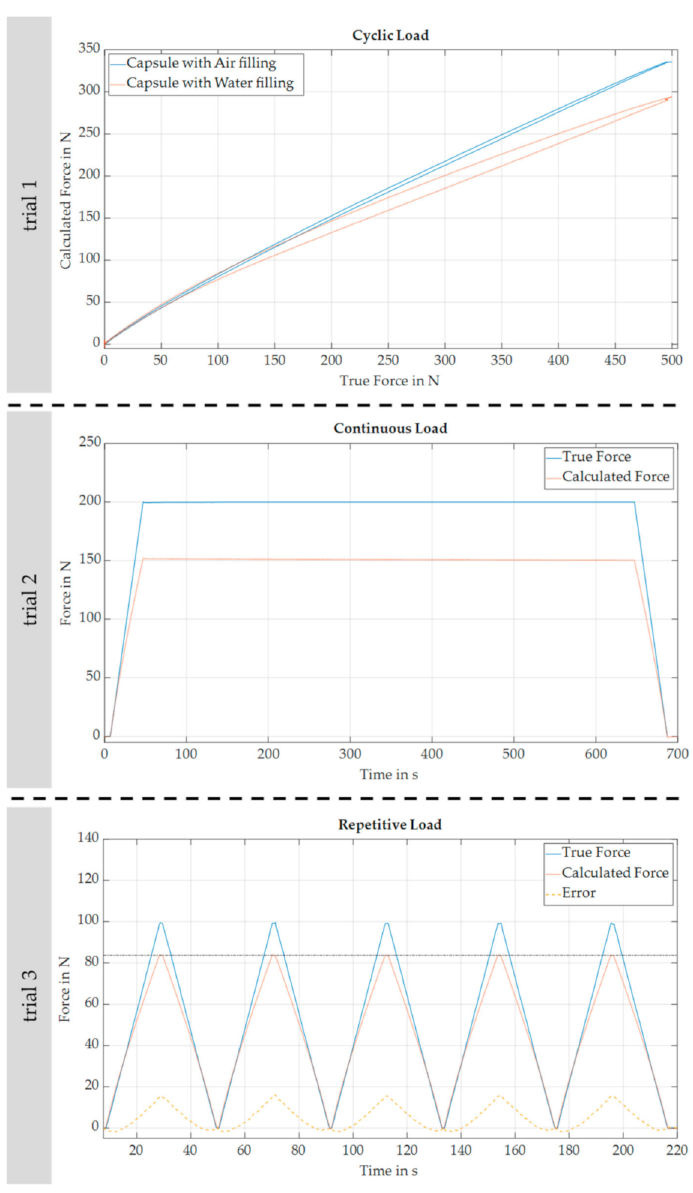
Figure 5. Measurement results in an isolated testing environment. The abscissa represents either the true force (see trial 1) or the elapsed time (see trial 2 and 3) in the respective trial. The ordinate always displays the calculated force of the sensor pad as well as for trial 2 und 3 the true force as